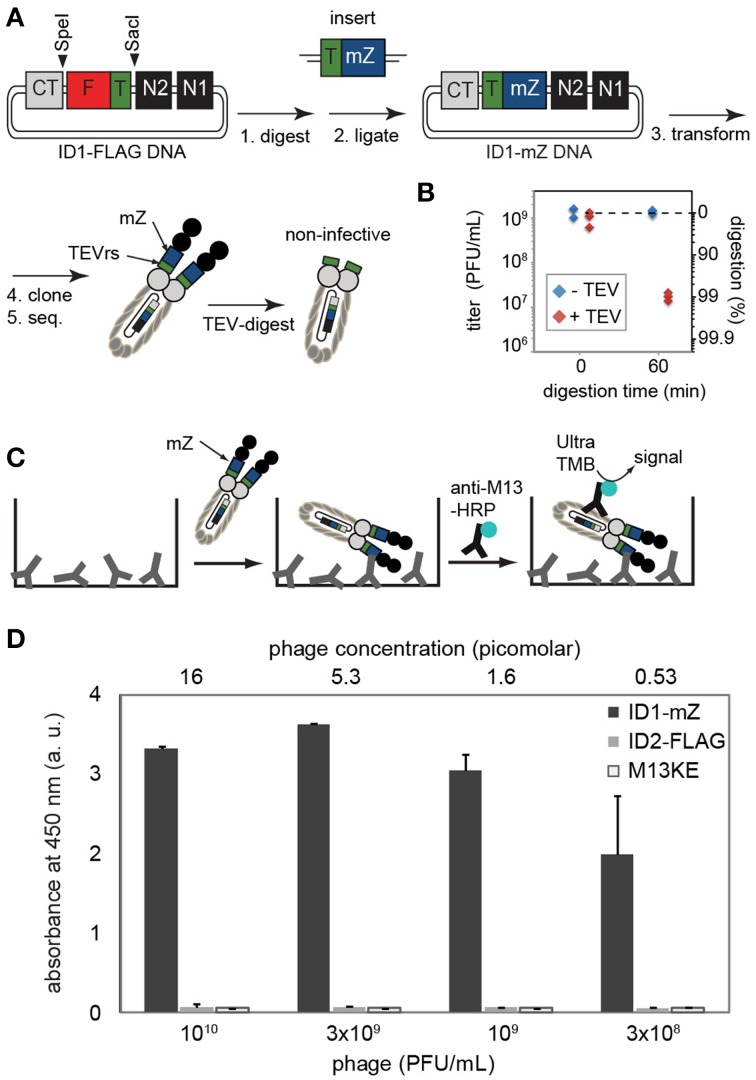
(A) Steps toward displaying mZ protein and TEV recognition sequence. The complete sequence of the cloned construct is provided in Supplementary Materials. (B) Digestion by TEV-protease validates that at least 99% of phage contained the insert and lost infectivity in the presence of this protease. Phage do not lose infectivity in a solution that has all components (reducing agents, buffers, salts) but no TEV-protease. (C,D) The presence of inserted FLAG sequence can be validated by ELISA on wells coated by IgG antibody that binds to the mZ domain. Phage were detected using HRP-conjugated anti-M13 antibody and Ultra-TMB substrate for HRP. ID2-PhD phage that displayed FLAG sequence or original M13KE phage that displayed no sequence exhibited no binding to IgG-coated wells. Data represents average from three independent wells; error bar is one standard deviation.